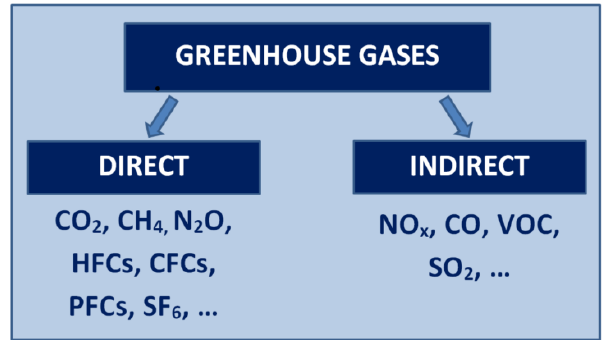
Figure 3. The division of GHGs including direct and indirect GHGs.